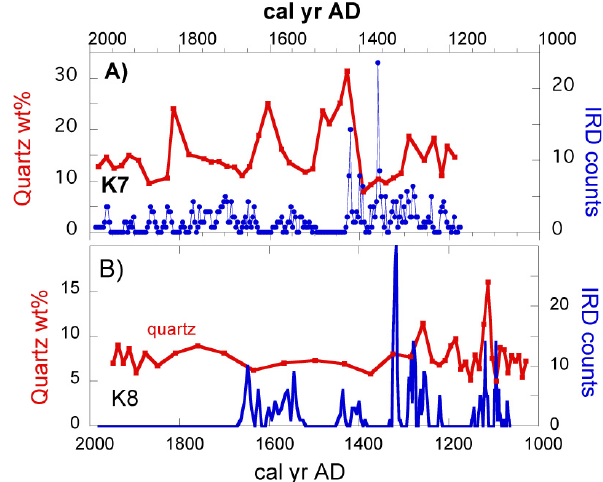
Fig. 6. IRD (blue) and quartz wt% data (red) from BS1191-K7 (A) and -K8, outer Kangerlussuaq Fjord (B) (Tables 1 and